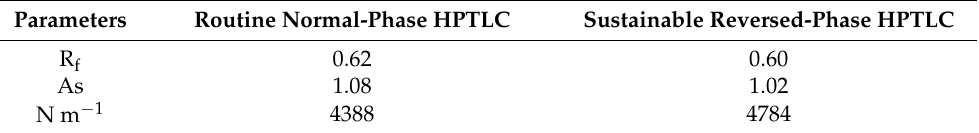
Table 2. System suitability parameters in terms of retention factor (R f ), asymmetry/tailing factor (As), and number of theoretical plates per meter (N m − 1 ) of PT for the routine normal-phase HPTLC and the sustainable reversed-phase HPTLC techniques.